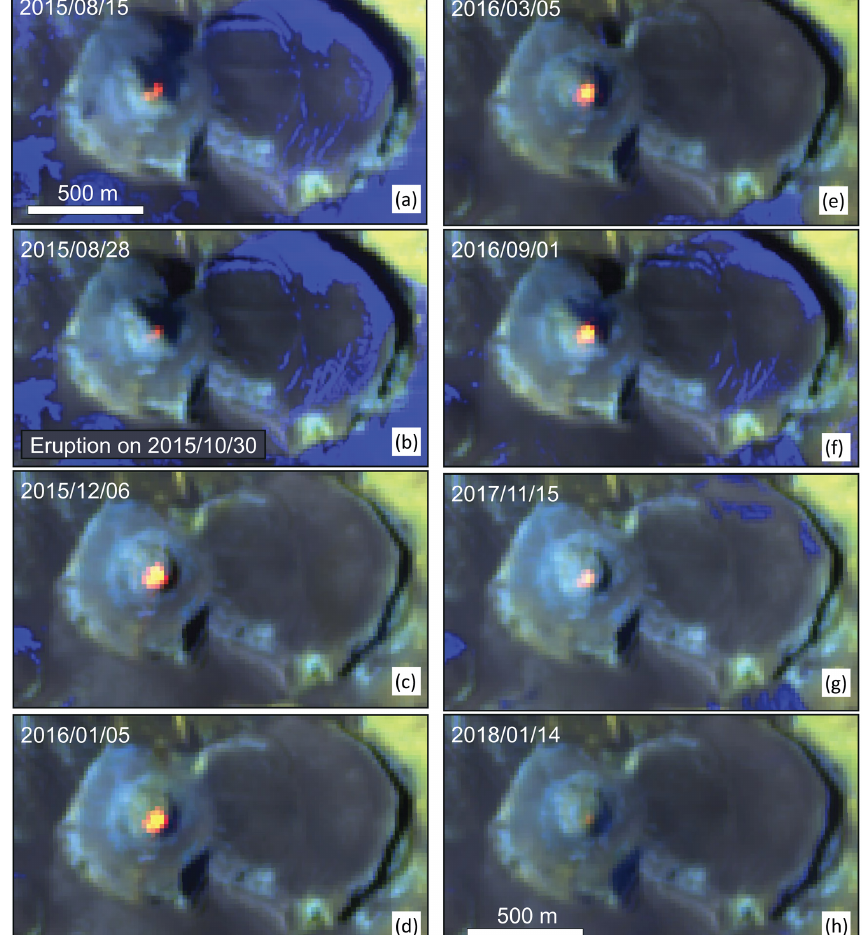
Figure 3. Satellite thermal anomalies (high temperatures are shown in red, while cold temperatures and snow are shown in blue) retrieved from Sentinel-2. The availability of data is irregular in 2015, but the data show a gradual decrease in the thermal anomaly in August 2015 and a later increase in the thermal anomaly on 6 December 2015, followed by a gradual decrease. Note that between 28 August 2015 and 6 December 2015 no clear Sentinel-2 images were acquired. (g) shows the thermal anomaly during the time of our UAV field campaign shown in Fig. 7. Data provided by the European Space Agency